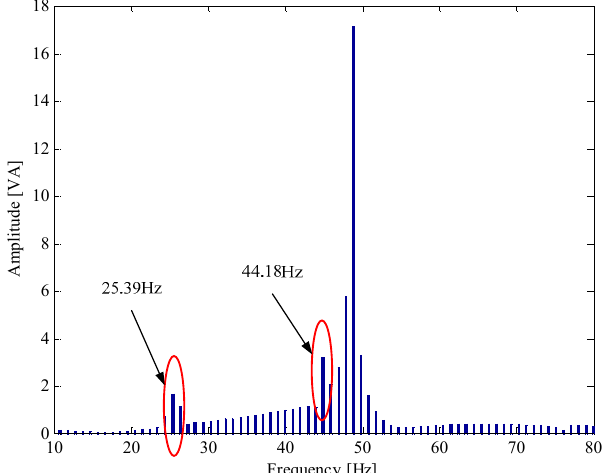
Figure 6. Wavelet packet decomposition tree for decomposition of the original signal.